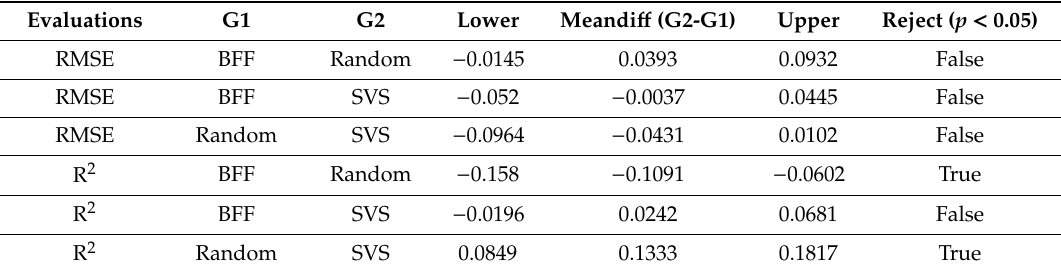
Table 7. Tukey’s test for different psychographic variables.